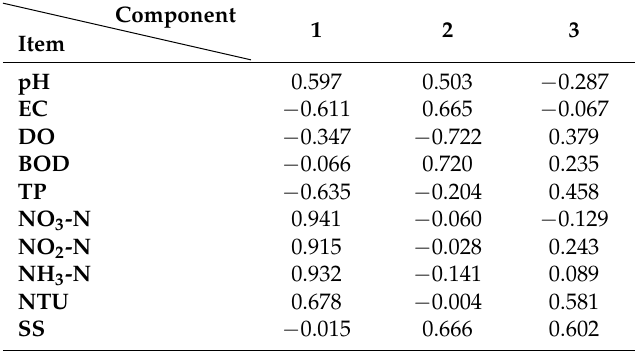
Table 3. Load matrix of the principal components of each water quality